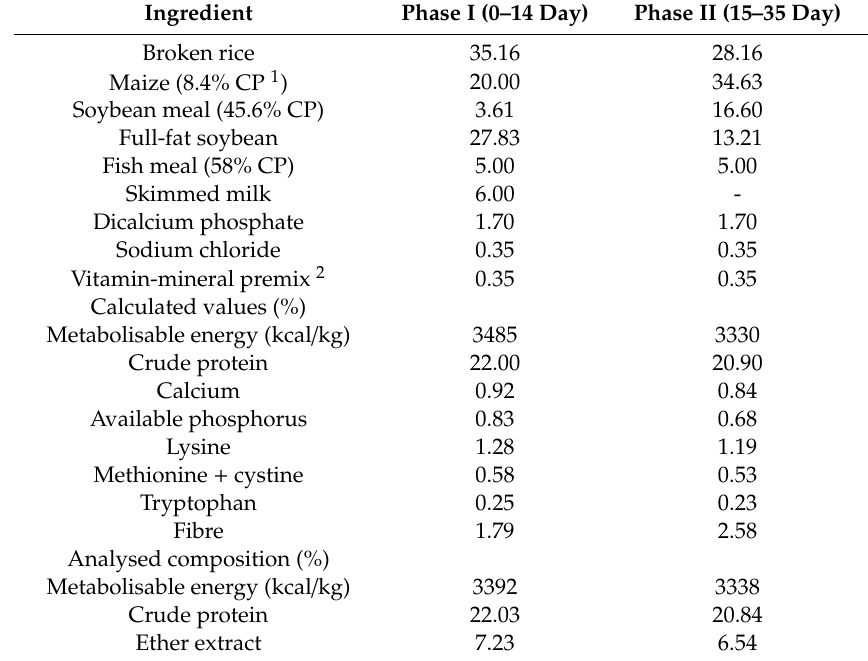
Table 2. Ingredients and chemical composition of basal diet (% as fed